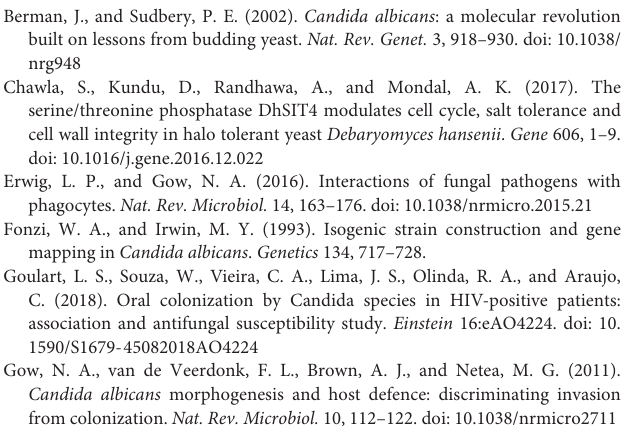
FIGURE S1 | Sequence alignment of S. cerevisiae Sap155 and Candida albicans Sap155 (orf19.642), S. cerevisiae Sap190 and C. albicans Sap190 (orf19.5160) Completely conserved residues are colored cyan. FIGURE S2 | The location of nucleus in sit4 (cid:49) / (cid:49) , sap155 (cid:49) / (cid:49) , sap190 (cid:49) / (cid:49) , and sap155 (cid:49) / (cid:49) sap190 (cid:49) / (cid:49) cells. Yeast cells of C. albicans strains of the indicated genotype were stained with DAPI to visualize the nucleus. Size bars = 12 µ m. FIGURE S3 | The hyphal growth of sit4 (cid:49) / (cid:49) , sap155 (cid:49) / (cid:49) , sap190 (cid:49) / (cid:49) , and sap155 (cid:49) / (cid:49) sap190 (cid:49) / (cid:49) mutants in DMEM. Late-log phase yeast cells of SC5314, sap155 (cid:49) / (cid:49) , sap190 (cid:49) / (cid:49) , and sap155 (cid:49) / (cid:49) sap190 (cid:49) / (cid:49) strains were re-inoculated at 1:20 dilution into fresh DMEM and incubated at 37 ◦ C with shaking at 200 rpm. Photos were taken at 1 h and 3 h. Size bars = 16 µ